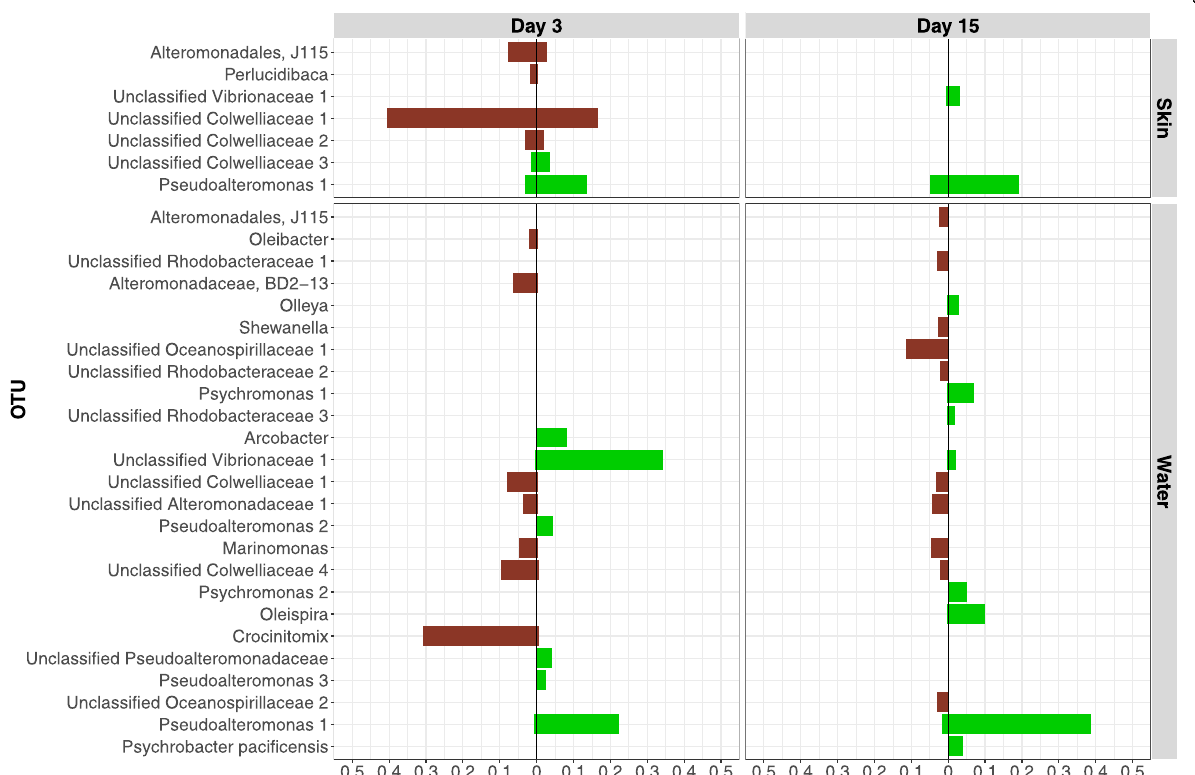
Fig. 4 OTUs that are significantly different ( p < 0.035) between claywater (CC) and greenwater (GG) treatments, faceted by sample type and date. The relative abundance of each OTU in the groups being compared is given on the x-axis. OTUs enriched in the CC treatment are represented by the brown color, and OTUs enriched in the GG treatment are represented by the green color. Different OTUs that have the same taxonomy are designated with different numbers (1 – 5), i.e., Unclassified Colwelliaceae 1 and Unclassified Colwelliaceae 2 are different OTUs. OTUs that share the same name and, if applicable, same number are the same OTU